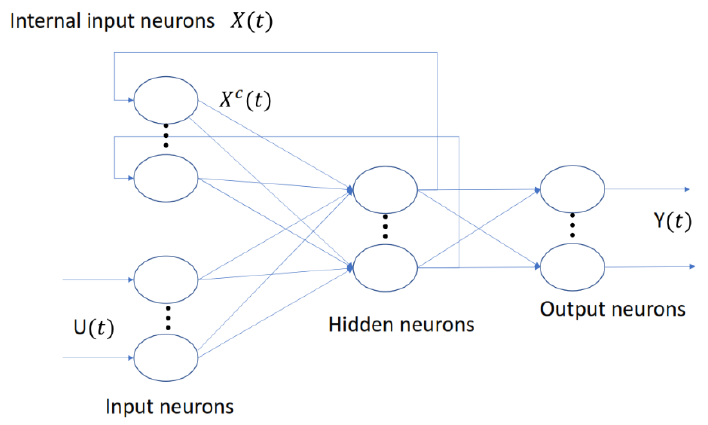
Figure 1. Elman recurrent network base diagram [36].